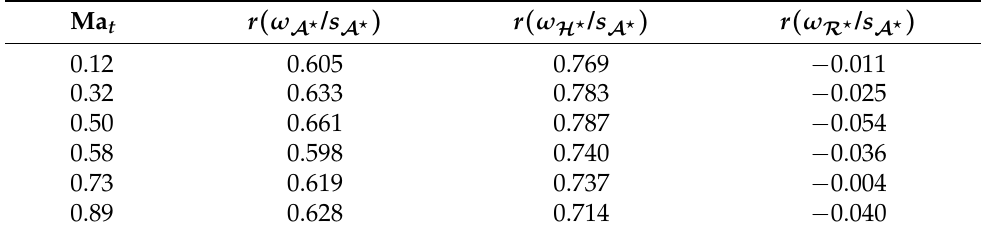
Table 3. Coefficients of correlation between ω A (cid:63) / s A (cid:63) , ω H (cid:63) / s A (cid:63) , and ω R (cid:63) / s A (cid:63)